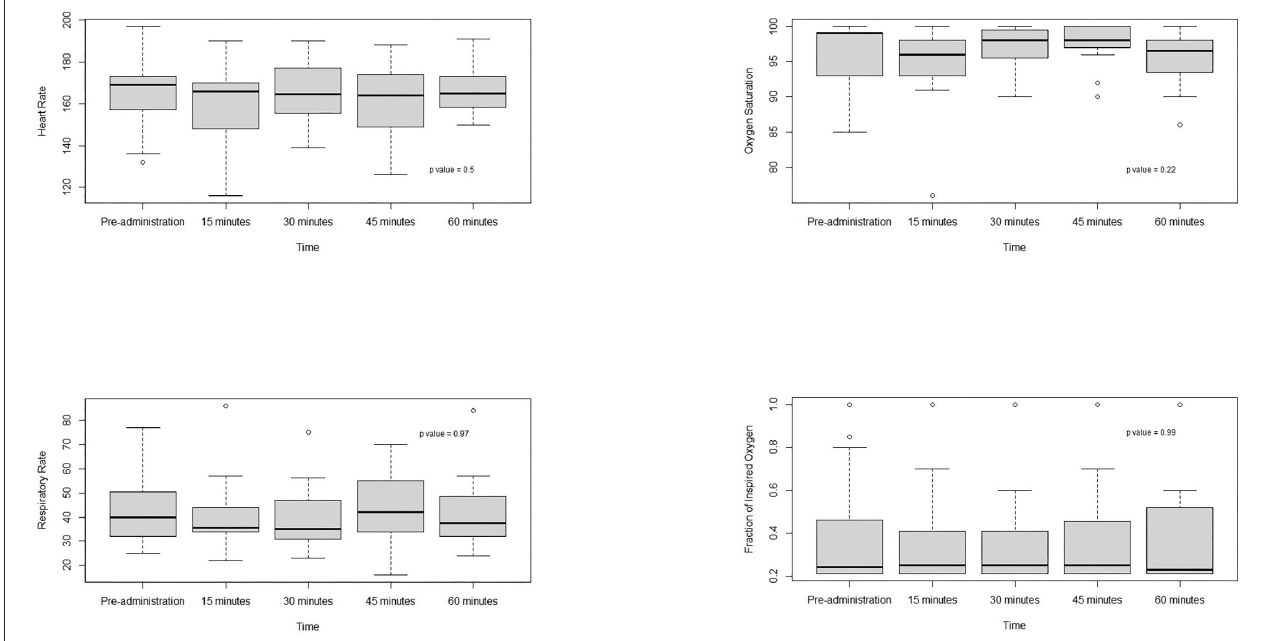
FIGURE 1 | Physiological parameters before and up to 60 min after IN fentanyl